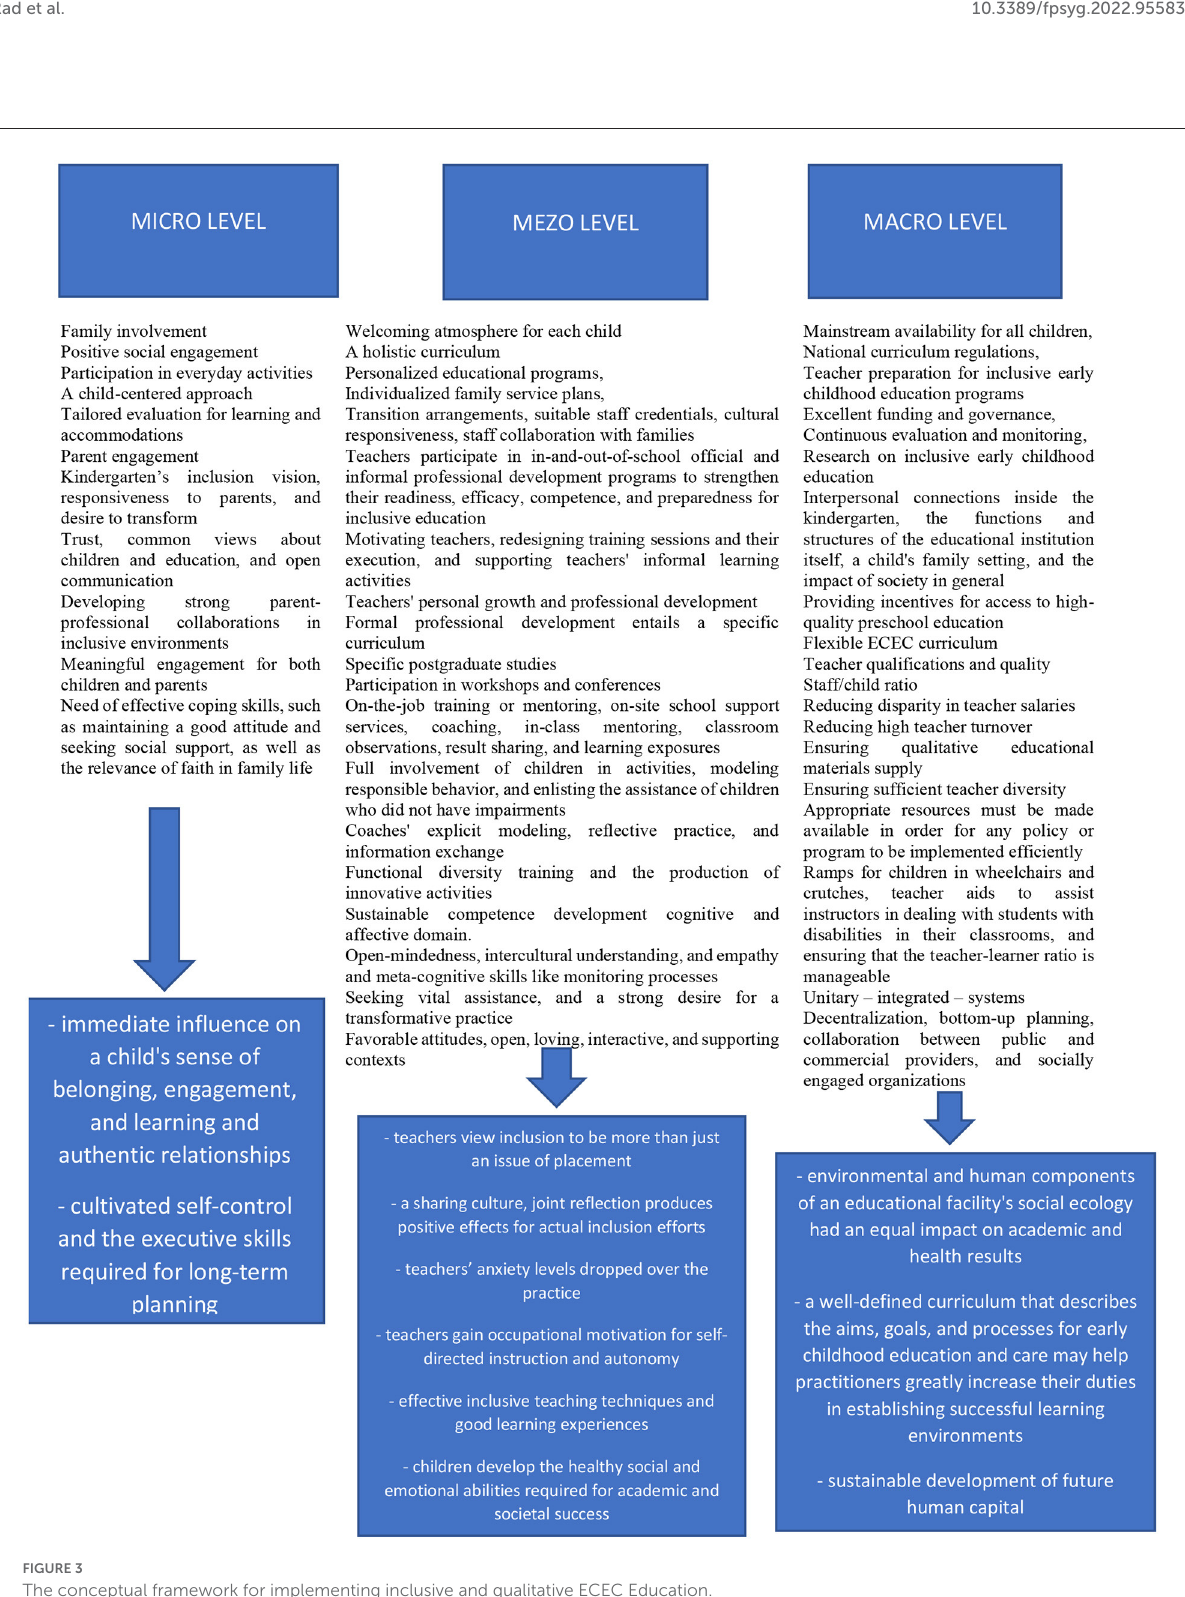
FIGURE3 The conceptual framework for implementing inclusive and qualitative ECEC